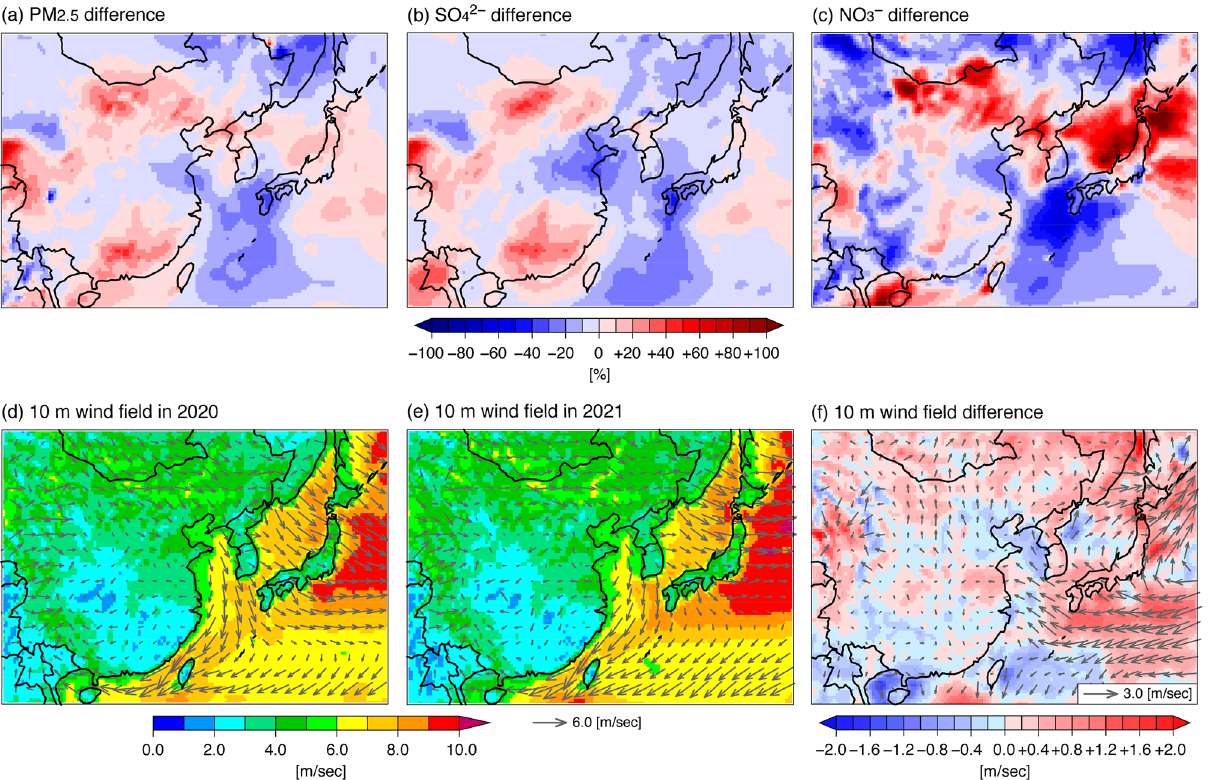
Figure 4. Changes in ( a ) PM 2.5 , ( b ) SO 4 2− and ( c ) NO 3 − concentrations during and after COVID-19 due to meteorology and changes in natural emissions by calculating the M21E20 values minus the M20E20 ones. Modelled 10-m wind field (colour denotes 10-m wind speed) in ( d ) 2020 (M20) and ( e ) 2021 (M21), and change in 10-m wind field by calculating the M21 WRF meteorological field minus the M20 one. The analysed period is the average of February and March. The maps were generated with gtool3 (http:// www. gfd- dennou. org/ libra ry/ gtool/ index. htm.